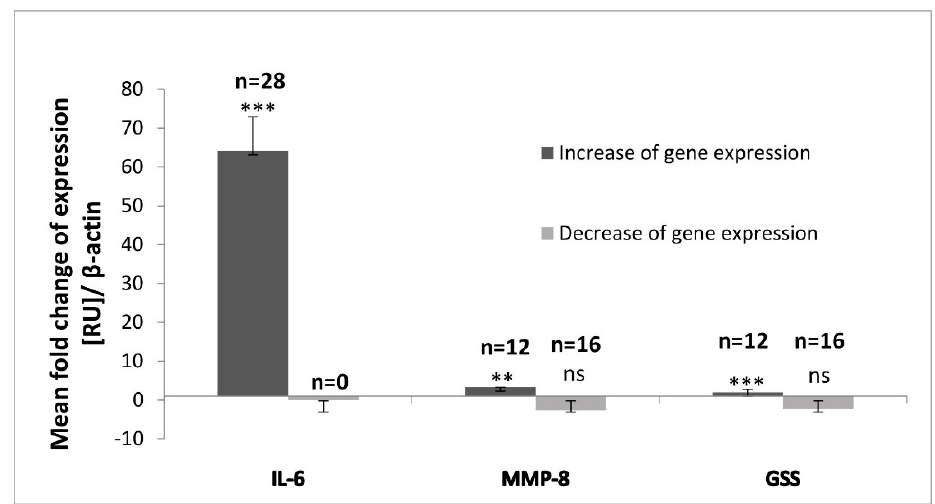
Figure 1. Mean fold-change of interleukin-6 (IL-6), matrix metalloproteinase-8 (MMP-8), glutathione synthetase messenger RNA (GSS mRNA) levels for the total investigated group of 28 children with diagnosed pyelonephritis. All fold changes are presented as mean for the total group versus a control group of nine children with no common health disorders. The expression of each gene of interest in the control group is considered to be equal to 1. Expression levels are presented in relative units (RU) ± SEM and human β -actin was used as endogenous control to normalize mRNA levels of IL-6, MMP-8 and GSS in each sample. ** p < 0.01 versus control group; *** p < 0.001 versus control group; ns—not significant.